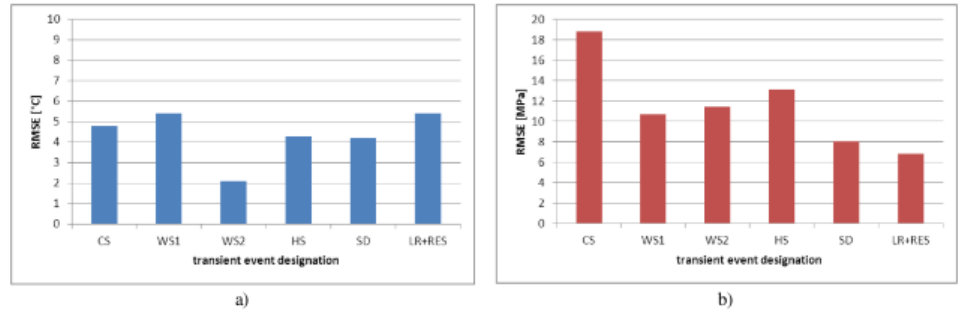
Figure 8: Neural network performance based on experimental data: a) temperature, b)